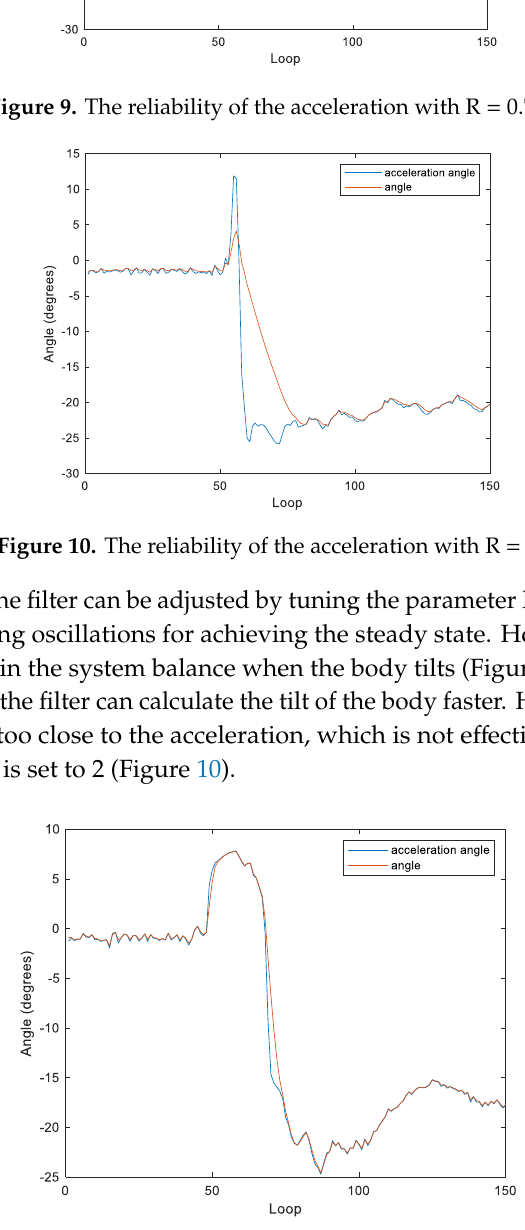
Figure 11. The reliability of the acceleration with R = Figure 11. T he reliability of the acceleration with R = 5.